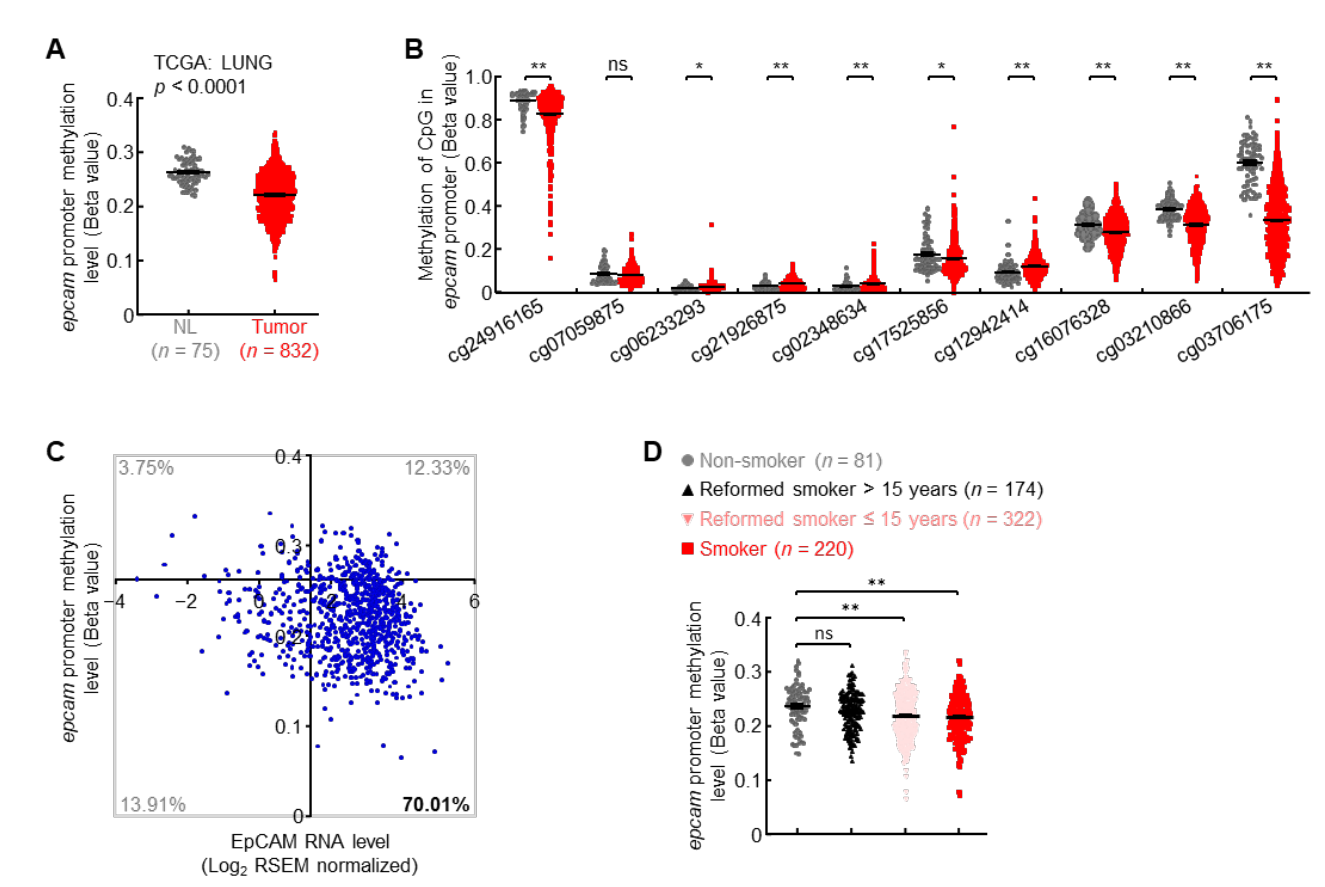
Figure 3. Promoter hypomethylation induces EpCAM expression in primary lung cancer. ( A ) TCGA LUNG data showing decreased epcam promoter methylation in human primary lung cancer. ( B ) TCGA LUNG data showing methylation status of each CpG site in epcam promoter in human primary lung cancer. ( C ) TCGA LUNG data showing epcam promoter hypomethylation in about 70% of lung cancers with increased EpCAM expression. Axis x and y cross at mean value (1.45, 0.26) of EpCAM expression level and promoter methylation level in normal lung. ( D ) TCGA LUNG data showing negative association between smoking and epcam promoter methylation. Student’s t test (two-tailed, unpaired) was performed. Data represent means ± SEM ( A , B , D ). * p < 0.05; ** p < 0.01; ns, not statistically different.